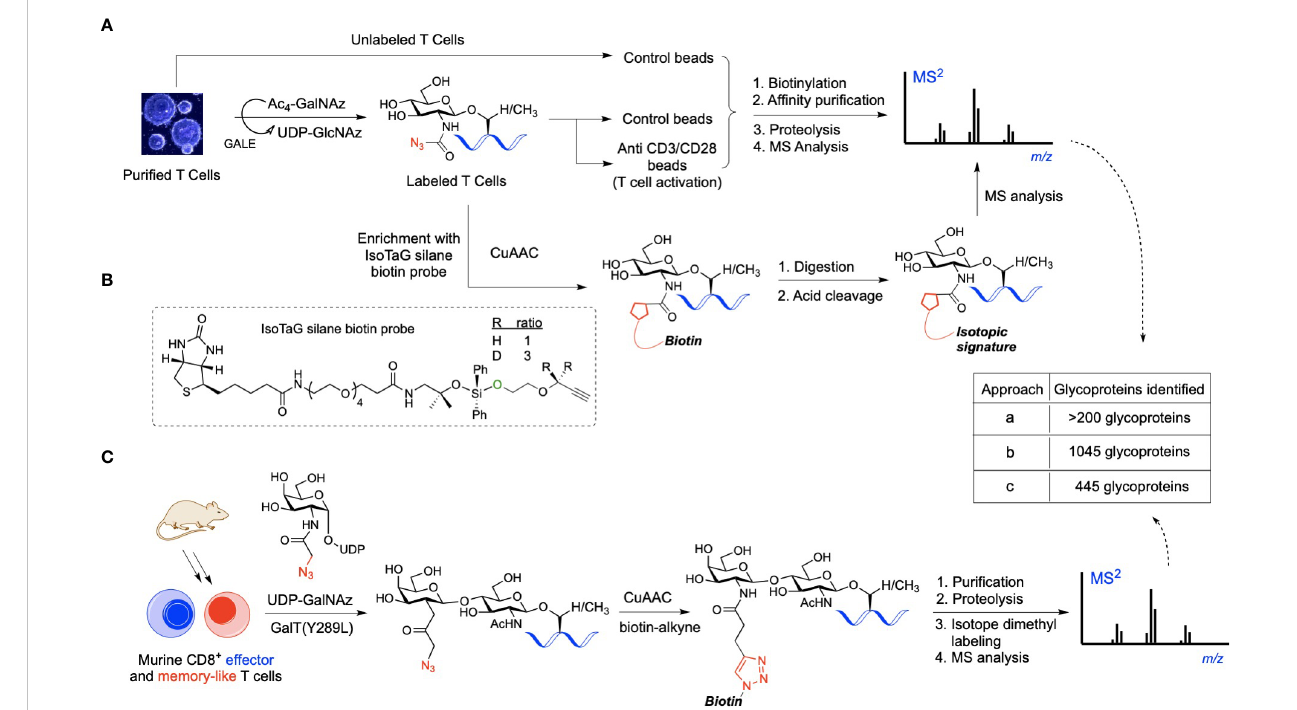
FIGURE 1 (A) Work fl ow of O -GlcNAc metabolic labeling for the identi fi cation of O -GlcNAc proteins in activated human T cells. Cells were incubated with Ac 4 GalNAz and stimulated with control beads or anti-CD3/CD28 beads for T cell activation. Azido-labeled proteins were biotinylated for af fi nity enrichment using streptavidin beads, then puri fi ed and digested for MS analysis, identifying relevant O -GlcNAc proteins. (B) IsoTaG labeling strategy involving click chemistry-based tagging of the azido-labeled proteins with the IsoTaG silane probe incorporating an acid-cleavable biotin and an isotopic label with a terminal alkyne. Biotinylated glycoproteins were af fi nity puri fi ed, digested, and retrieved via acid-mediated cleavage for subsequent LC-MS/ MS sequencing. (C) Chemoenzymatic pro fi ling of O -GlcNAc proteins in mouse CD8 + effector- and memory-like T cells using UDP-GalNAz as the unnatural nucleotide donor. Probing of the GalNAzylated O -GlcNAc proteins with a biotin tag via click-chemistry, followed by af fi nity puri fi cation,